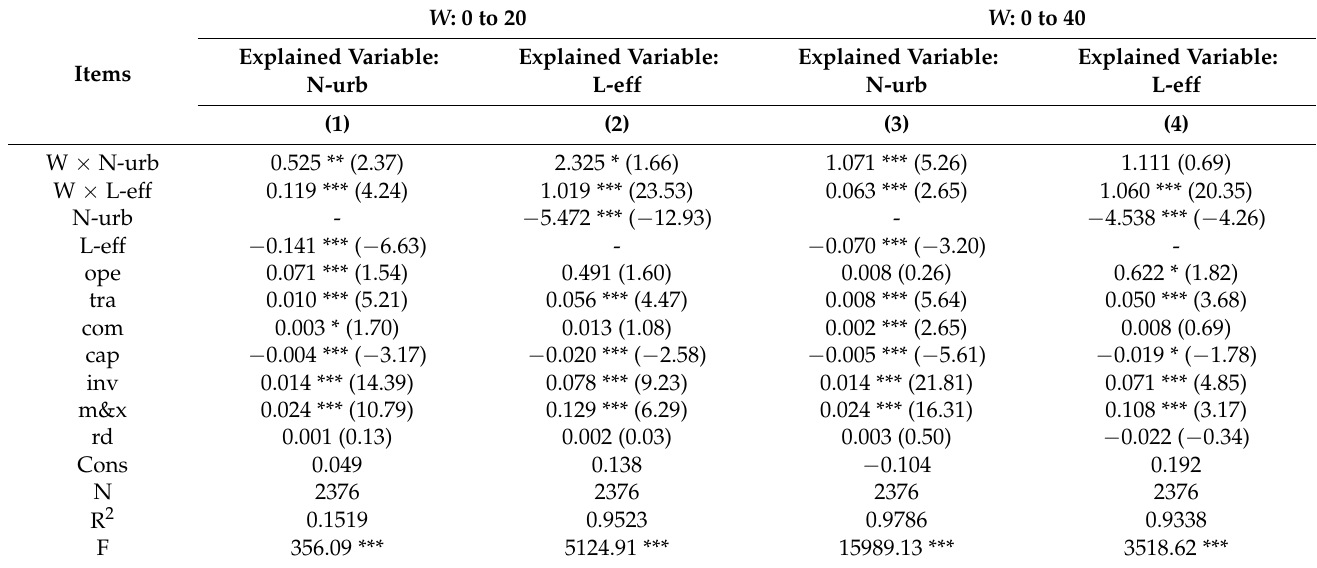
Table 7. Robustness test results of distance band